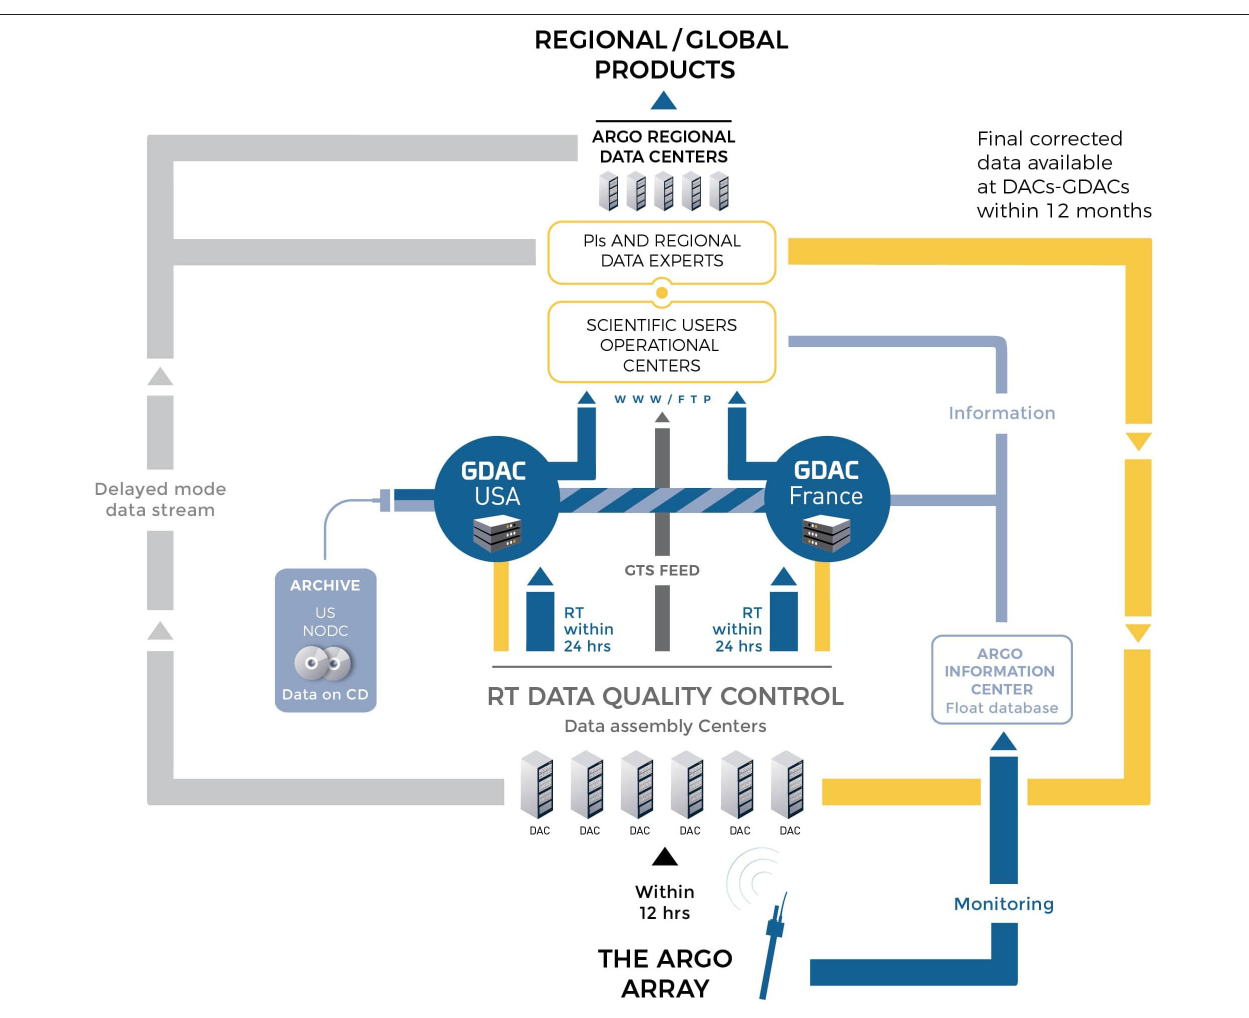
FIGURE 4 | Components of the Argo data system and their interactions. [Source: Euro-Argo ERIC].